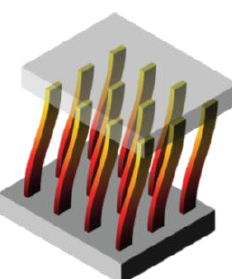
Figure 16. ZnO nanoribbons array presented by Majidi et al . [75] ( © IOP Publishing. Reproduced with permission of IOP